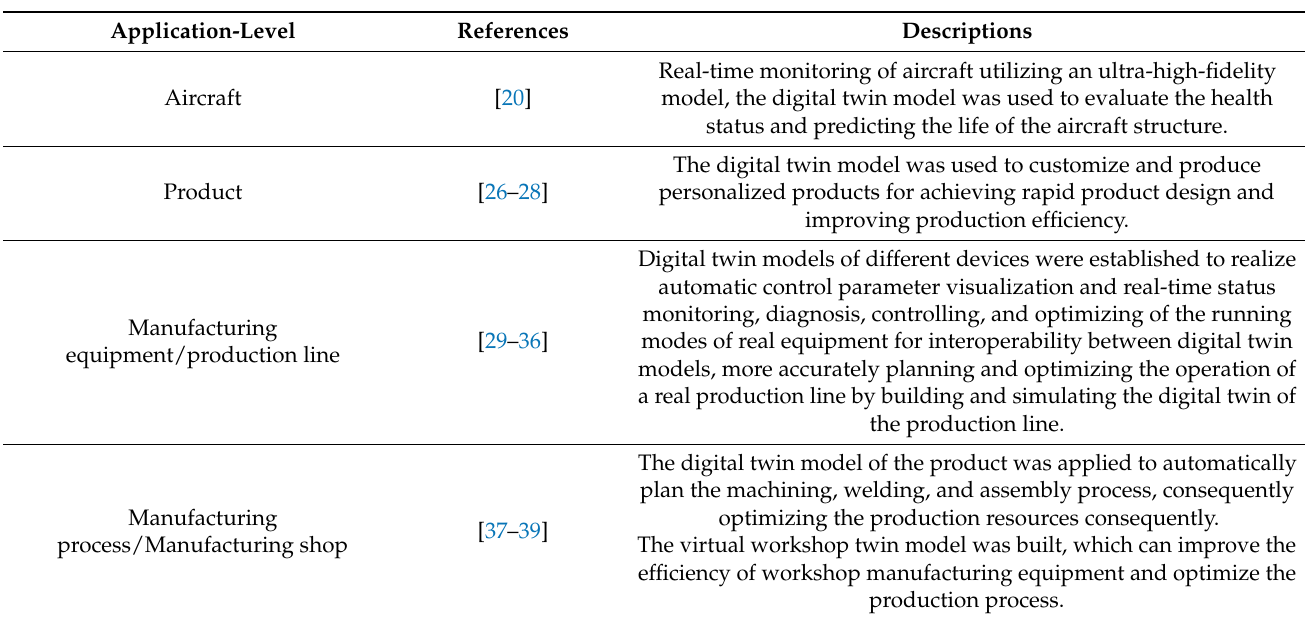
Table 1. Application research of the digital